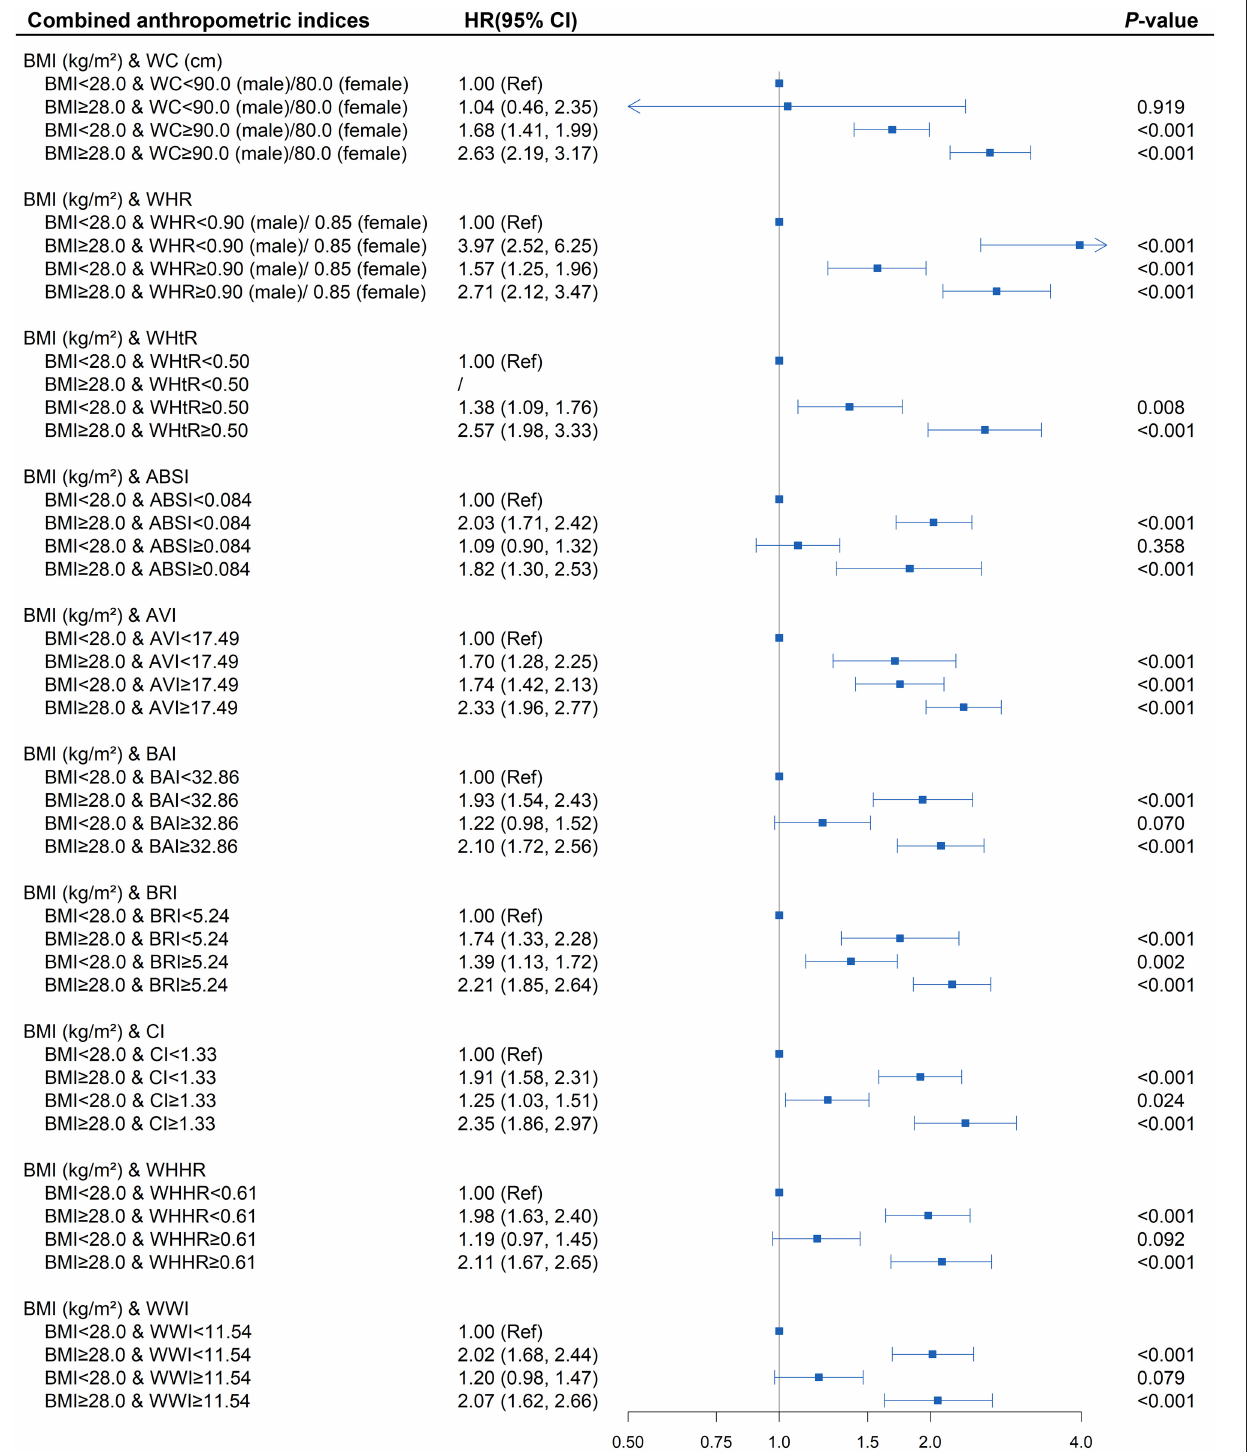
FIGURE 3 | Association between different combinations of body mass index (BMI) and anthropometric indices of central obesity (waist circumference [WC], waist-to-hip ratio [WHR], waist-to-height ratio [WHtR], a body shape index [ABSI], abdominal volume index [AVI], body adiposity index [BAI], body roundness index [BRI], conicity index [CI], waist-hip-height ratio [WHHR], weight-adjusted-waist index [WWI]) with diabetes. The correlation was assessed by multivariate cox regression analysis, adjusted by sex, age, smoking status, drinking status, fasting plasma glucose, serum triglycerides, total cholesterol, high-density lipoprotein, low-density lipoprotein, systolic blood pressure, and diastolic blood pressure at baseline. Hazard ratios (HRs) of the combined anthropometric indices were represented as the squares and 95% confidence intervals (CIs) by the lines through the squares.